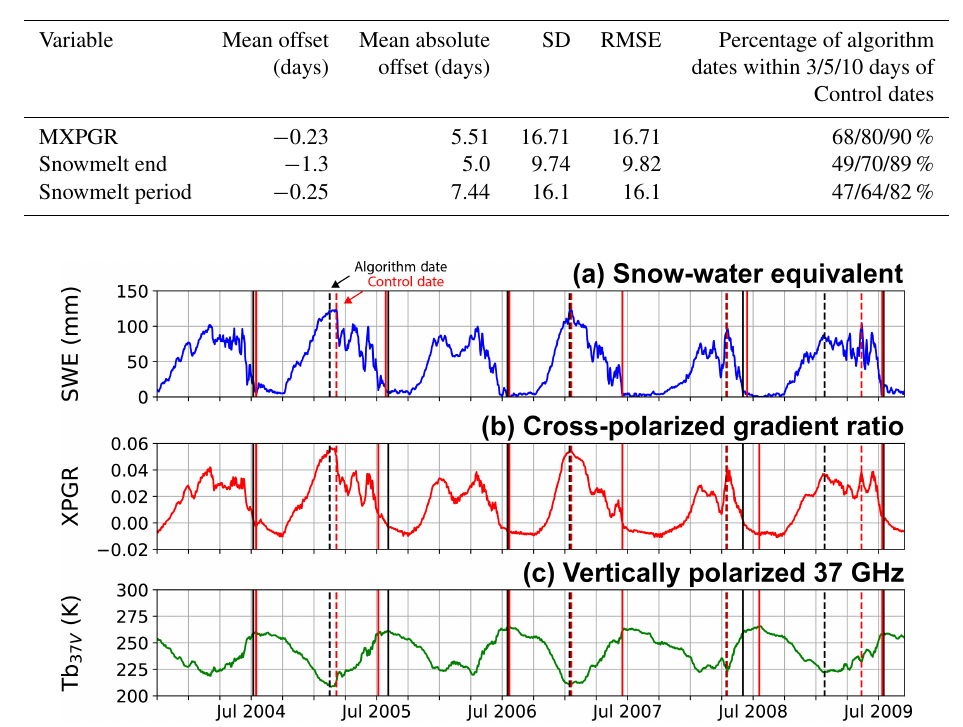
Table 1. Summary statistics comparing manual control dataset and algorithm dataset ( n = 2100, 28 snowmelt seasons at 25 locations).